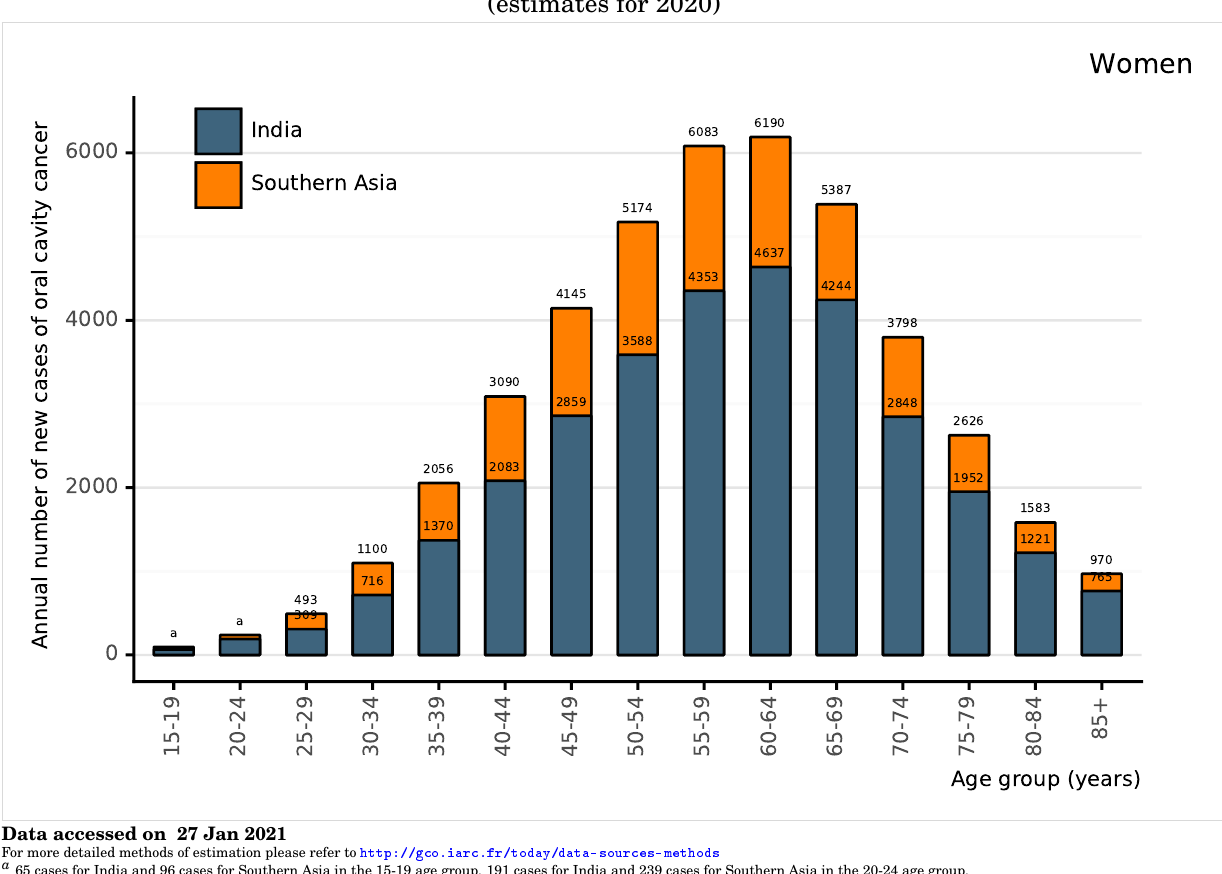
Figure 97: Annual number of new cases of oral cavity cancer among women by age group in